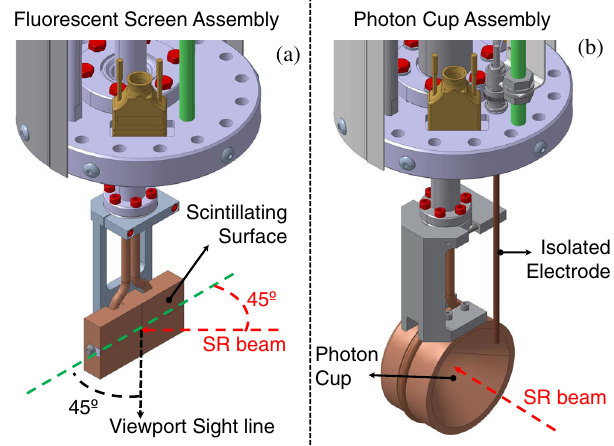
FIG. 4. 3D models of (a) a fluorescent screen assembly — the dashed arrows represents the geometry of the SR beam and the view port sight line with respect to the screen ’ s paddle; in both figures, the red arrow represents the direction of the sample ’ s longitudinal axis — and (b) the photon cup assembly of the BESTEX, where the conical OFHC bulk and the isolated clearing electrode can be